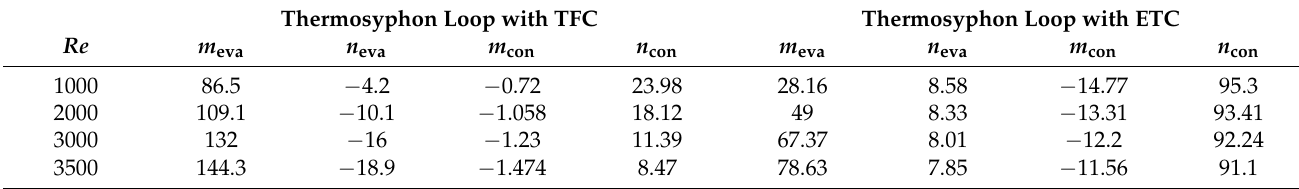
Table 4. Correlative coefficients of m eva,con and n eva,con in the a eva,con functions. Thermosyphon Loop with TFC Thermosyphon Loop with ETC